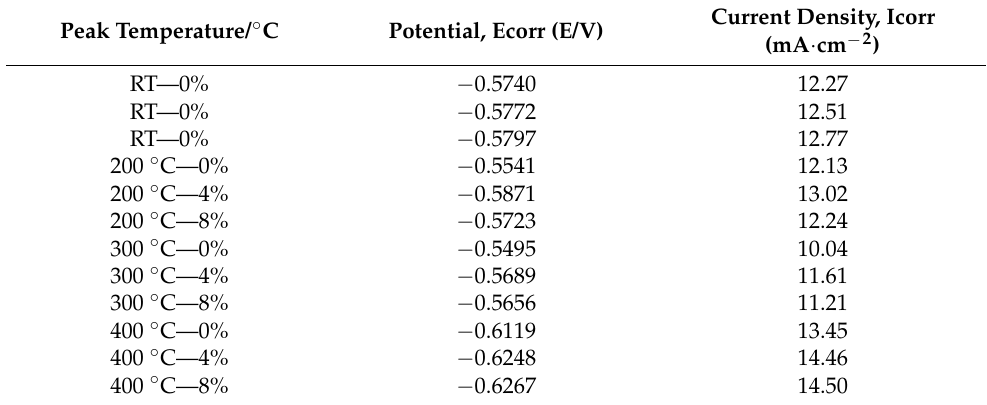
Figure 6. Potentiodynamic polarization curves of 2A12−T4 aluminum alloy at different thermal strain coupling parameters. Table 4. Fitting results of the potentiodynamic polarization curves of the 2A12-T4 aluminum